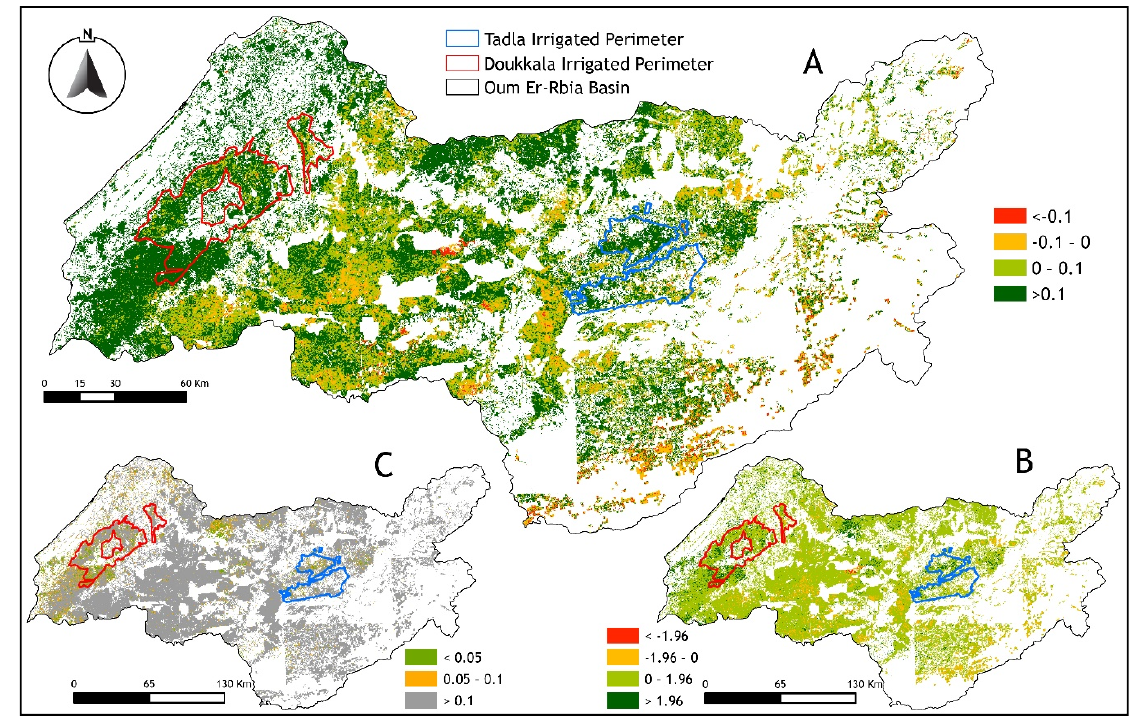
Figure 10. Spatial distribution of length of season (LOS) trend. Maps A, B, and C represent Sen’s slope values, Kendall Z, and p-value intervals, respectively.